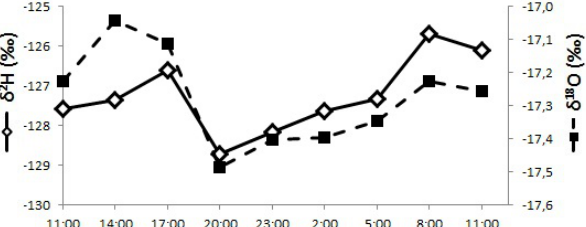
Fig. 10. Variation in δ 2 H and δ 18 O during 24h in the Juncal River. Samples were taken every three hours between 11:00LT (3 April) and 11:00LT (4 April)